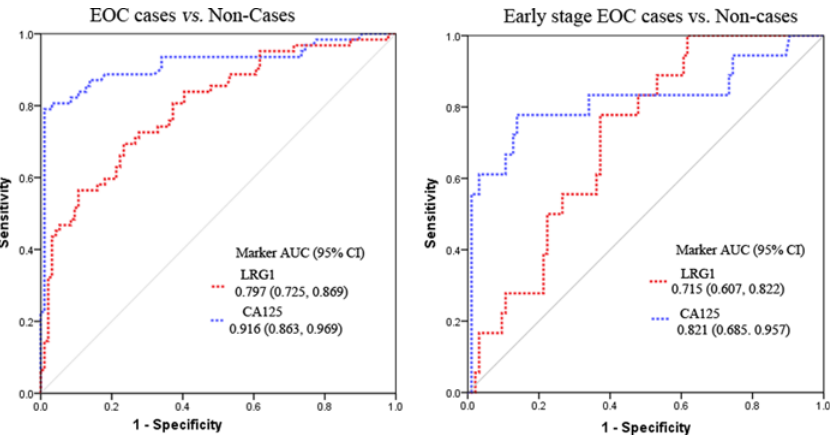
Fig 3. ROC curves comparing marker concentrations in cases to non-cases for sample set 1. (a) ROC analyses for CA125 and LRG1 to differentiate EOC from non-cases. (b) ROC analyses for CA125 and LRG1 to differentiate early stage EOC from